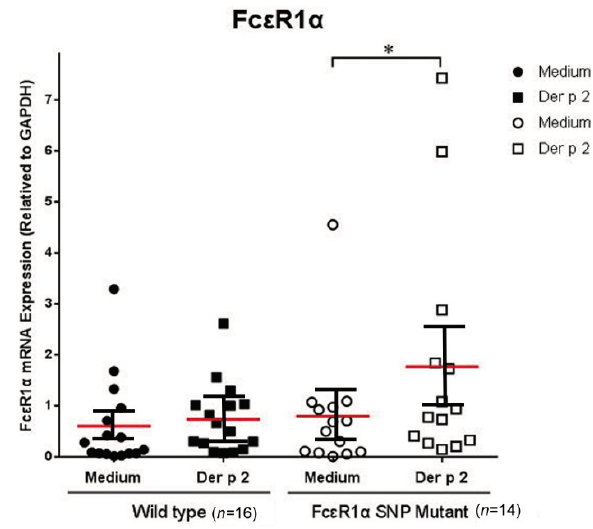
Figure 1. Genetic effect of genotypes rs2251746 ( − 95, T>C) and rs2427827 ( − 344, C>T) in the Fc ε R1 α promoter region on Fc ε R1 α mRNA expression. The PBMCs were cultured